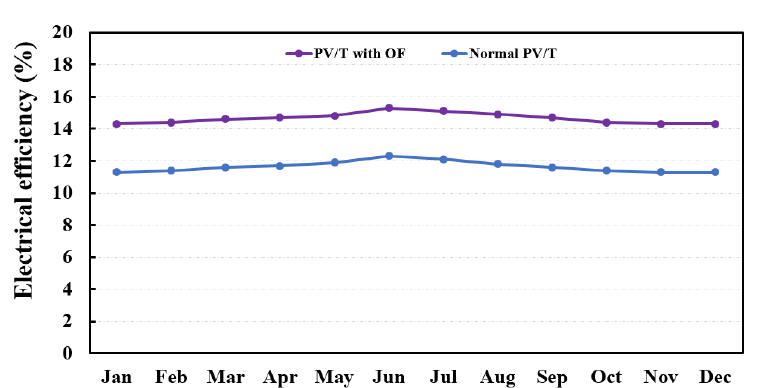
Figure 6. Electrical efficiency.